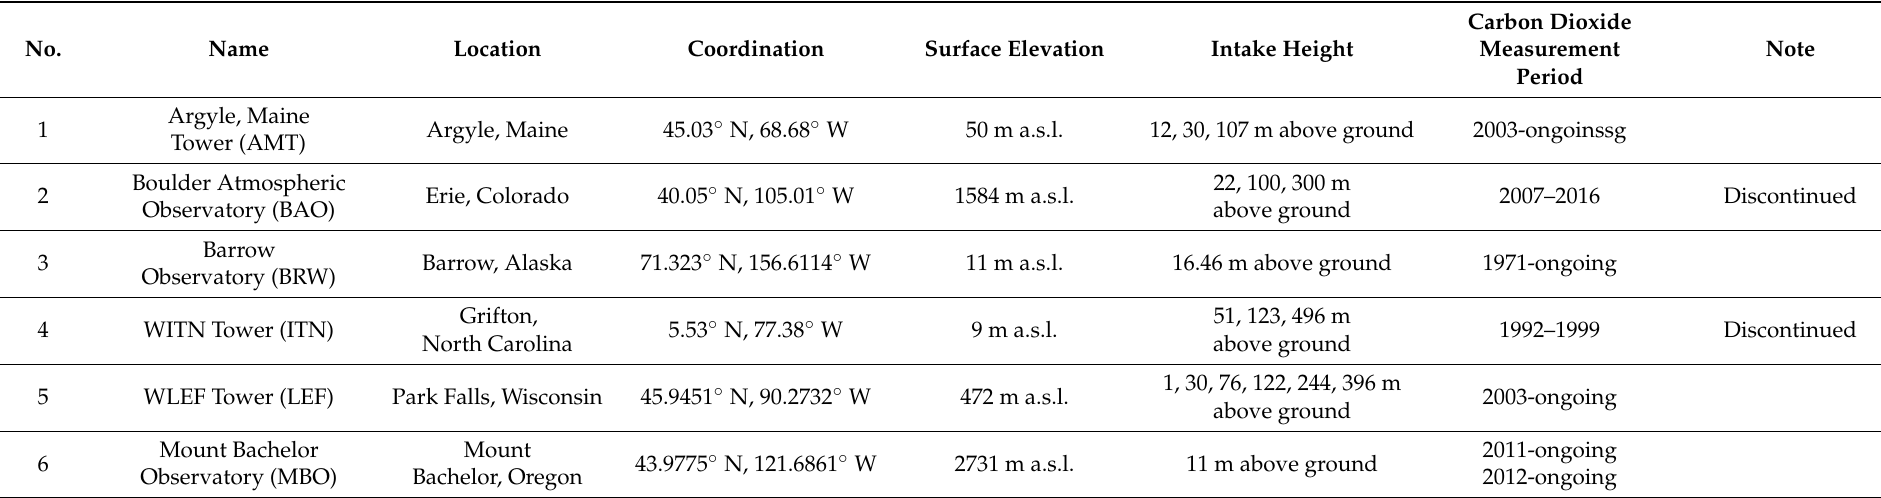
Table A6. Tall towers in the NOAA Earth System Research Laboratory’s Global Greenhouse Gas Reference Network